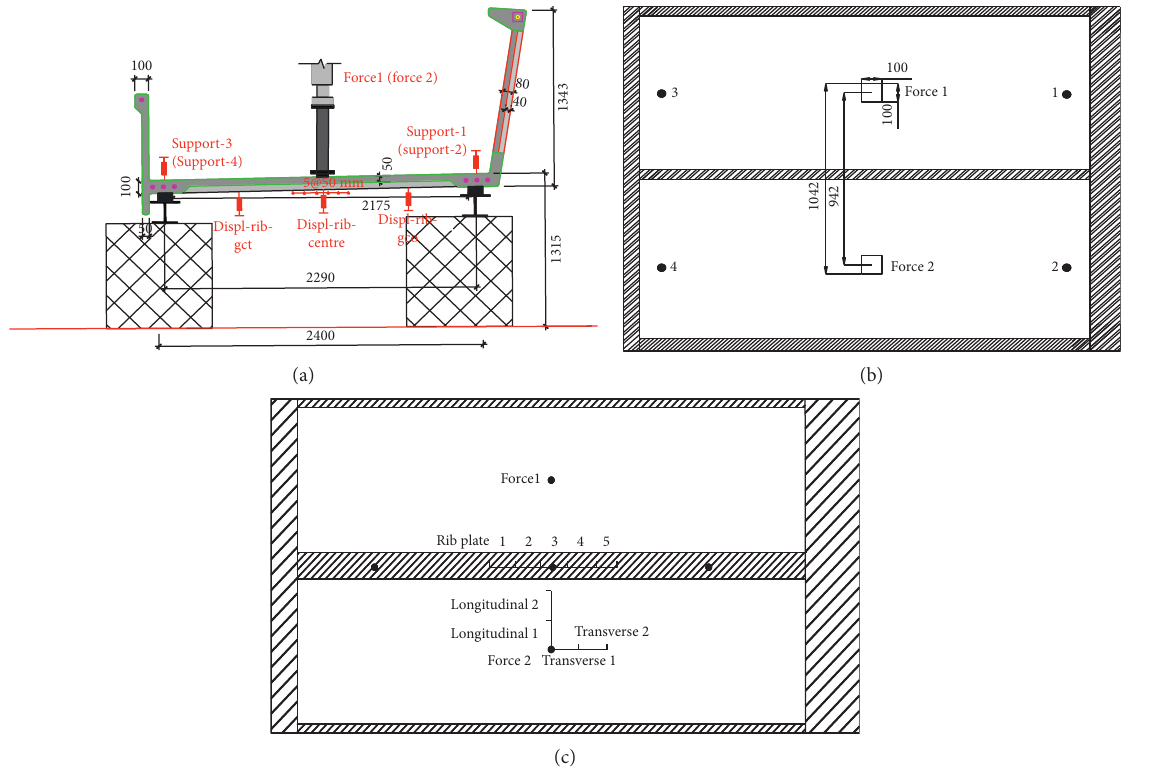
Figure 2: Positions of measuring points (unit: mm). (a) Test model elevation. (b) Test mode surface. (c) Test mode